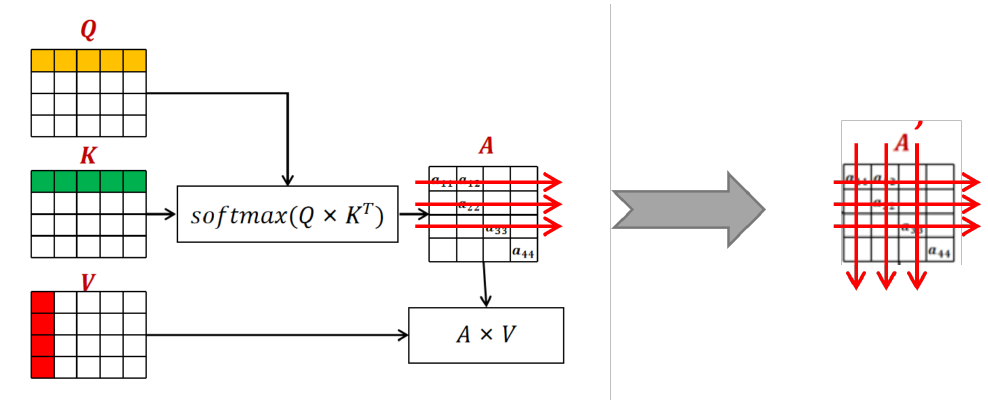
Figure 8. The row and column normalization of attention